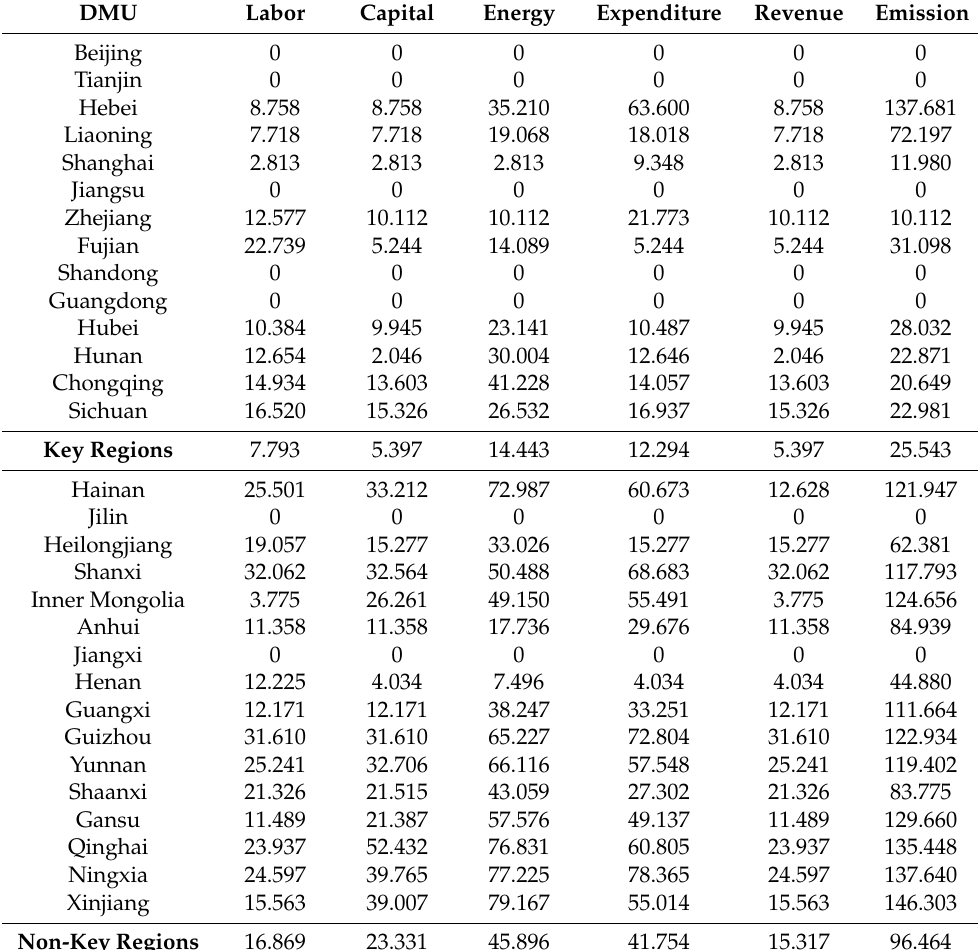
Table 5. Room for improvement of variables as average values from 2011–2015 unit: %. DMU Labor Capital Energy Expenditure Revenue